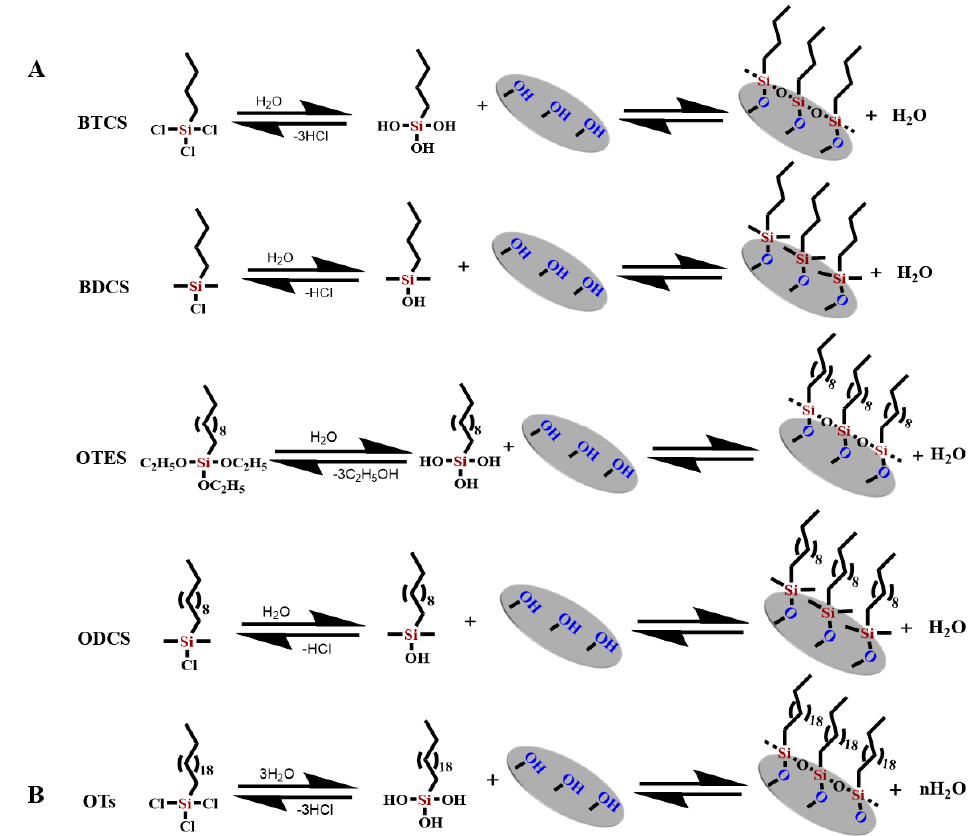
Figure 10. ( A ) Reaction schemes for modifications of glass fiber membrane with different organosil- icon derivatives. ( B ) Reaction scheme of glass fiber membrane with octadecyl trichlorosilane.